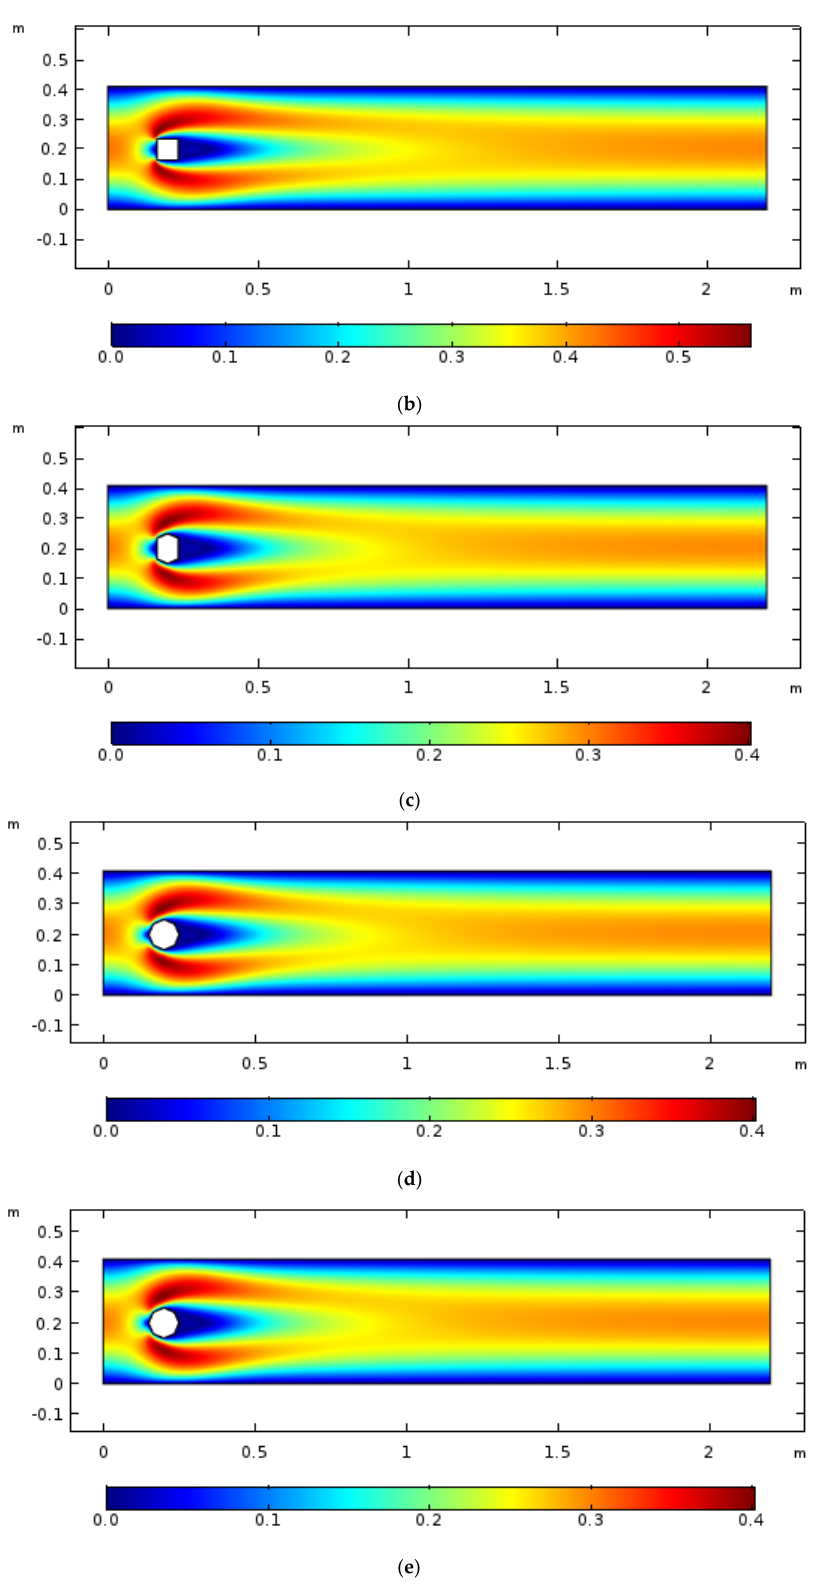
Figure 4. ( a ) Velocity distribution around triangular obstacle. ( b ) Velocity distribution around square obstacle. ( c ) Velocity distribution around hexagon obstacle. ( d ) Velocity distribution around octagon obstacle. ( e ) Velocity distribution around circular obstacle.